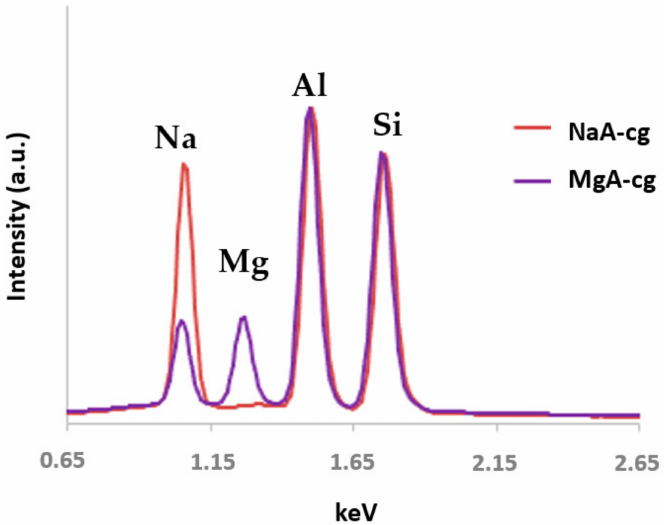
Figure A5. EDX spectra of NaA-cg and MgA-cg samples.